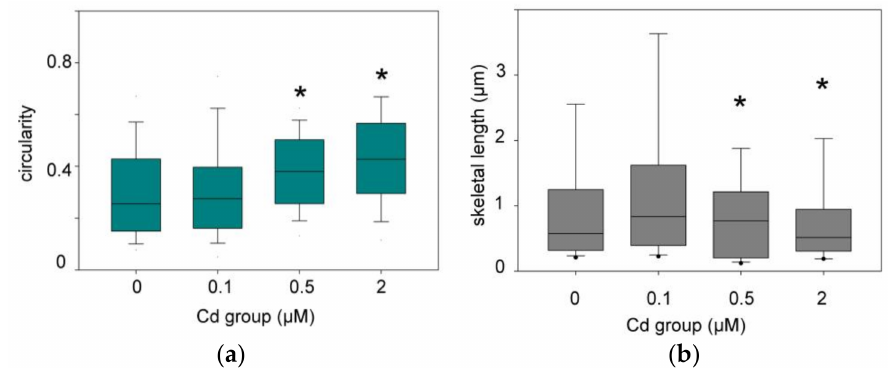
Figure 4. Box Plots showing the distribution of circularity ( a ) and skeletal lengths ( b ) of the mitochondrial network after 96 h of exposure to cadmium. * Kruskal–Wallis test p < 0.05 for the indicated groups compared to the reference one (0). The boundaries are the 25th and 75th percentiles and the median and error bars are